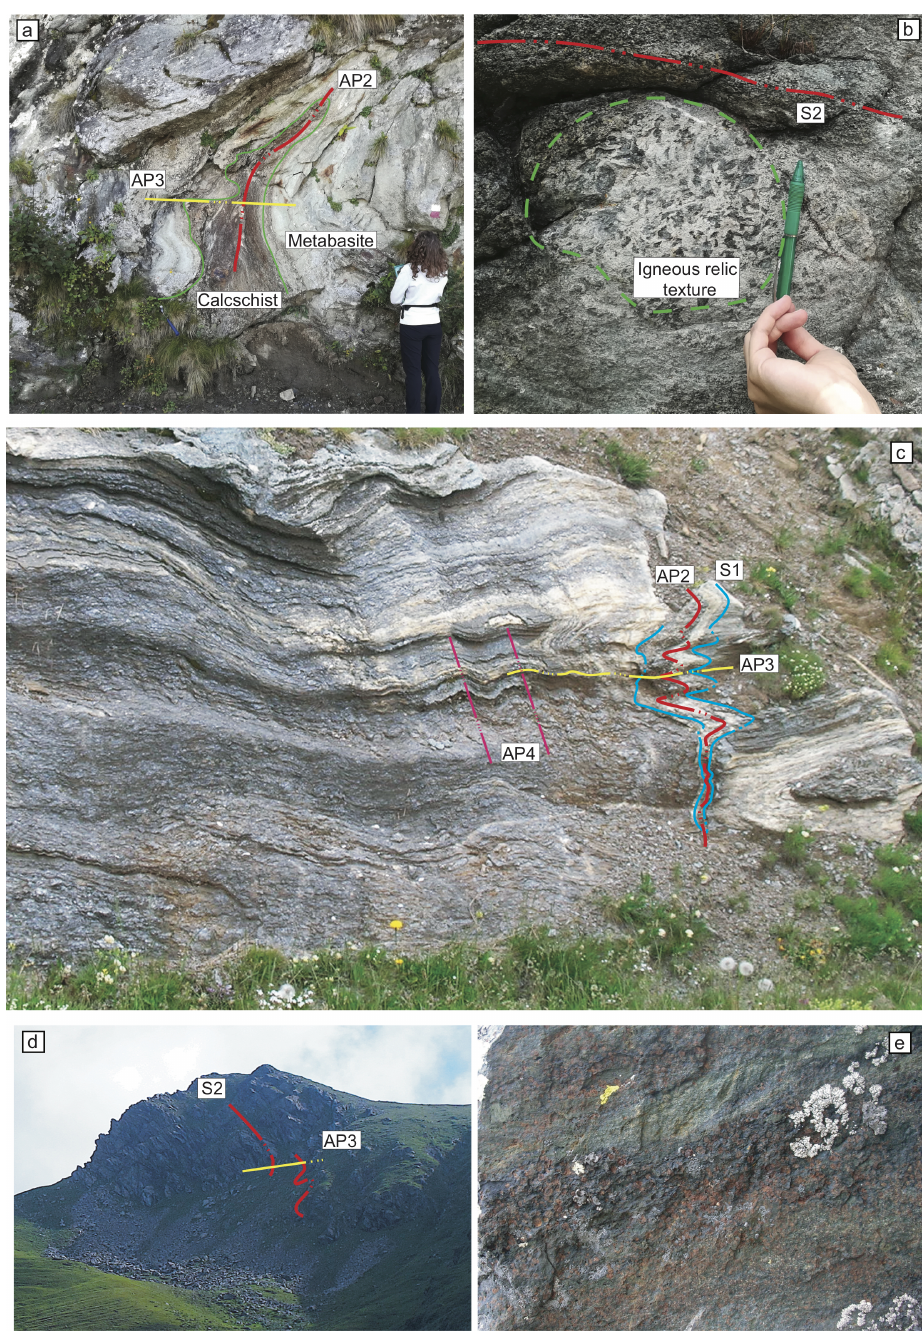
Figure 4. ( a ) Interference pattern of type 3 between D2 (isoclinal) and D3 (open) folds in metabasites and metasediments from the PZ. AP2 and AP3 indicate the traces of D2 and D3 fold axial planes, respectively. ( b ) Metabasite in which a relic volume with gabbroic texture with centimeter amphiboles is wrapped by S2. ( c ) White marble layers in calcschists of the PZ mark the overprinting relationships between S1 (light blue trace) D2 (red trace = AP2), D3 (yellow trace = AP3) and D4 (pink trace = AP4) folds. ( d ) P.ta Gias Vej is mainly constituted by serpentinites in which the dominant fabric is S2 (red trace) that is affected by D3 folding with slightly inclined axial plane (yellow trace). ( e ) Foliated eclogite relic in metabasite: alternating layers omphacite-rich (green) and garnet-amphibole-rich (dark blue with red spots) mark pre-S2 foliation. Eclogite relics generally occur in boudins, metric to hectometer in size, wrapped by S2 in metabasites. Long side of the photograph = 30